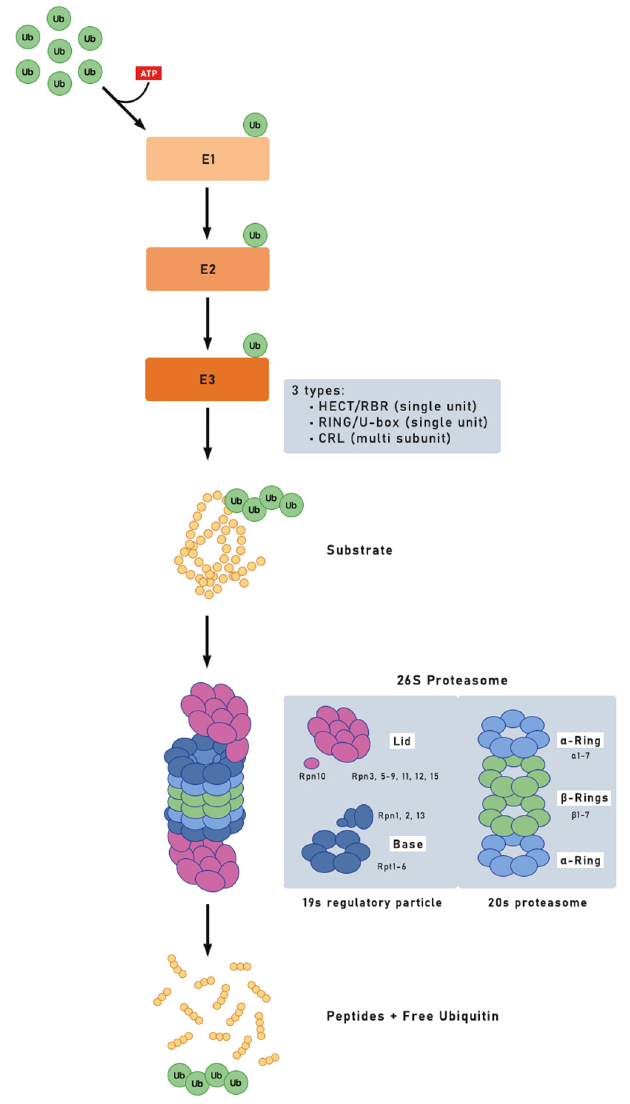
Figure 1. E1 activates a ubiquitin molecule (Ub) in an ATP-dependent reaction by forming a high-energy thioester bond between an E1 Cys residue and the carboxy-terminal Gly of ubiquitin. This activated ubiquitin is then donated to a Cys on an E2 by trans-esterification. In most cases, the ubiquitin–E2 intermediate serves as the proximal ubiquitin donor, using an E3 to identify the target and catalyze ubiquitin transfer. The final product is a ubiquitin conjugate. The C-terminal Gly carboxyl group of ubiquitin is linked through an isopeptide bond to an accessible amino group (typically a Lys ε -amino) in the target. Depending on what lysine was ubiquitinated, mostly K11 and K48, proteasome 26S could degrade the target protein.